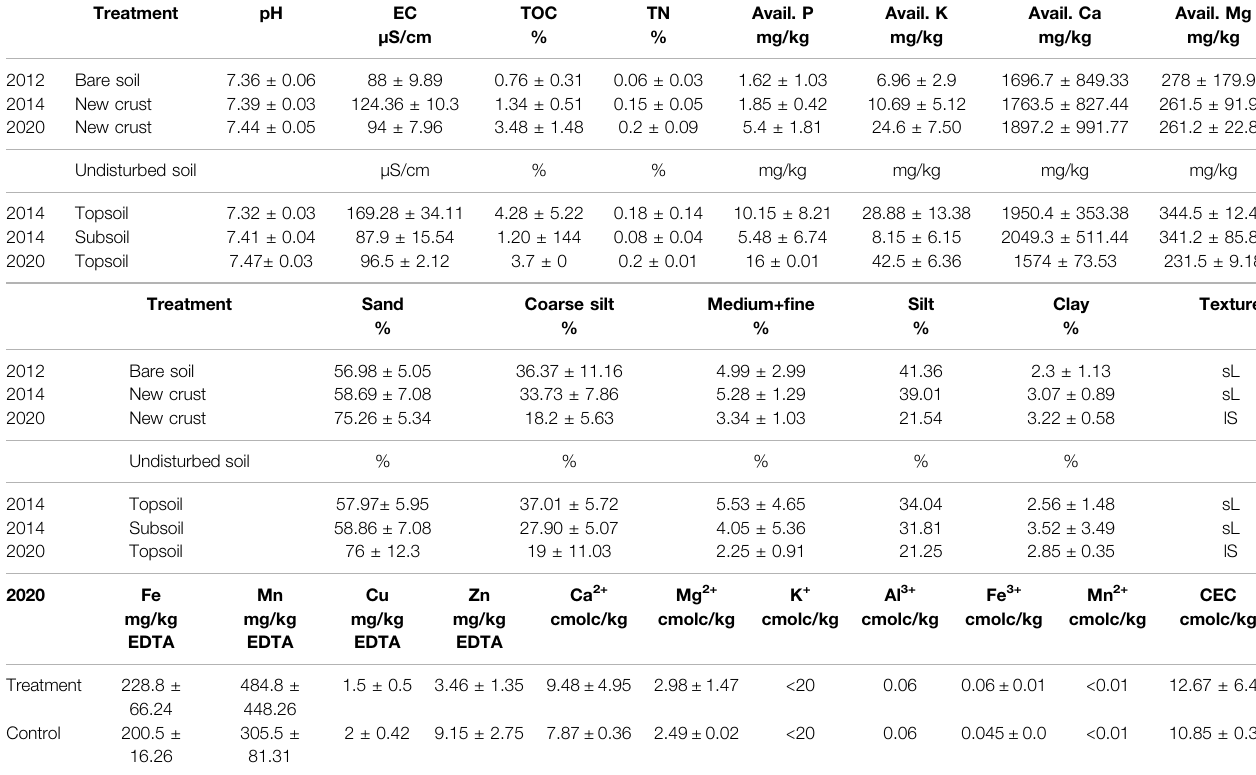
TABLE 2 | Main analytical data (arithmetic means and standard errors) of treatment and soil samples (2012, 2014, and 2020) at the Hochtor ( n = 5 – 10). Same of the data have already been published in (Peer et al., 2021). Treatment